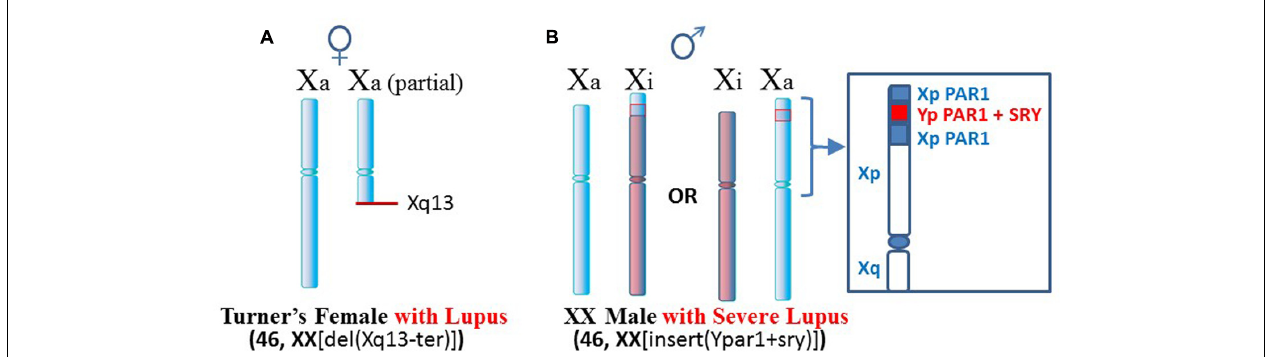
FIGURE 3 | Lupus in patients with X chromosome abnormalities. (A) A Turner’s syndrome patient with two X chromosomes but one X is missing distal portions of Xq and does not have a complete XIC at Xq13 (Cooney etal., 2009). As a result, X inactivation cannot occur and there is potential for